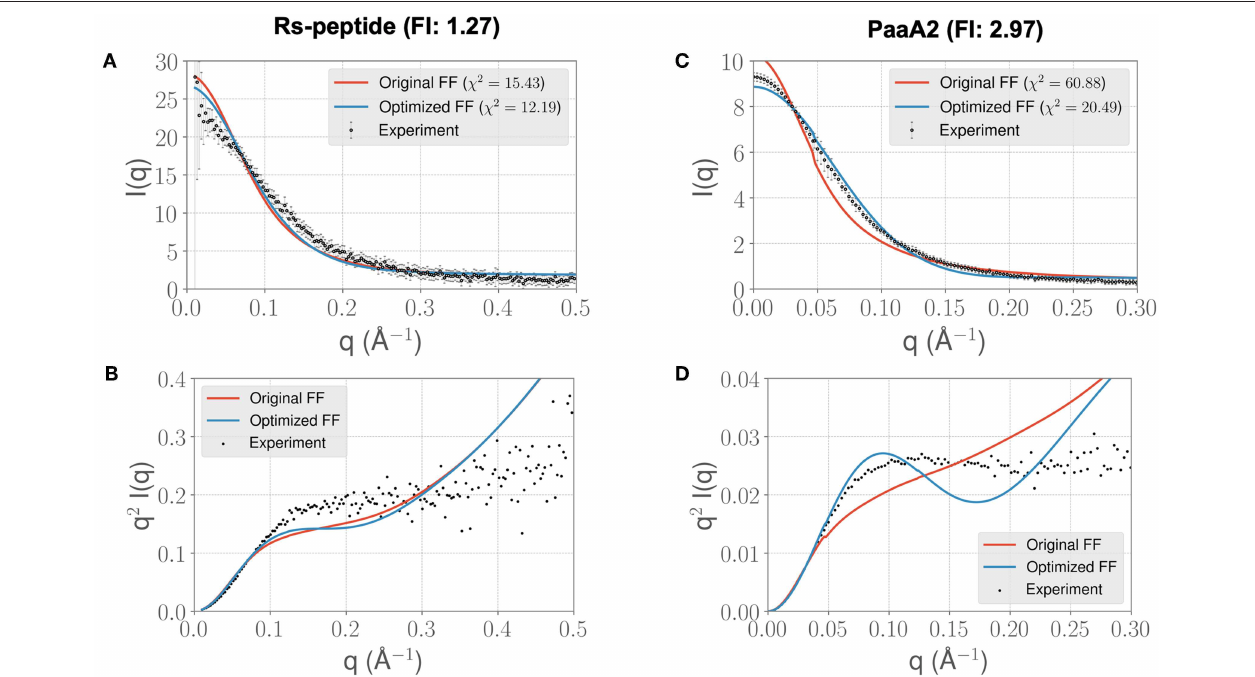
FIGURE 4 | Longer timescale simulations using the ForceBalance-SAS optimized FF parameters preserve improvement with experimentally observed scattering profiles. (A) The scattering profiles for RS-peptide showing the experimental data (black dots with error bars) along with the predicted SAXS scattering profiles from the original FF simulations (red lines) vs. the optimized FF simulations (blue lines). For clarity, the χ 2 values between the experiment and the respective simulations are shown in the legend. (B) The Kratky plot from experiments (black dots), and predicted profiles from simulations (red line corresponding to the original FF, blue line—optimized FF). For clarity, the error bars from the experiments are excluded. (C,D) Highlight the same comparison for the PaaA2 system. The factor improvement (FI) in the χ 2 values between the optimized and original FFs are listed above each protein system. Note that the FI in each simulation has decreased compared to the shorter timescales ( Figure 3 )—however, still preserves the overall trends. It is also notable that the fits of the MD simulations to the longer q values are poorer in both